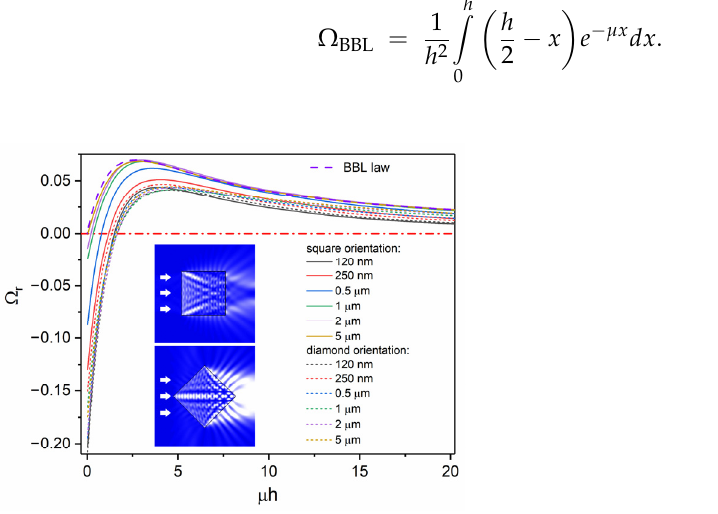
Figure 11. Ω r ( μ h ) dependences for crystals with square-shaped section of different thicknesses and orientation to the light ( λ = 400 nm). The arrows show the direction of the incident light.